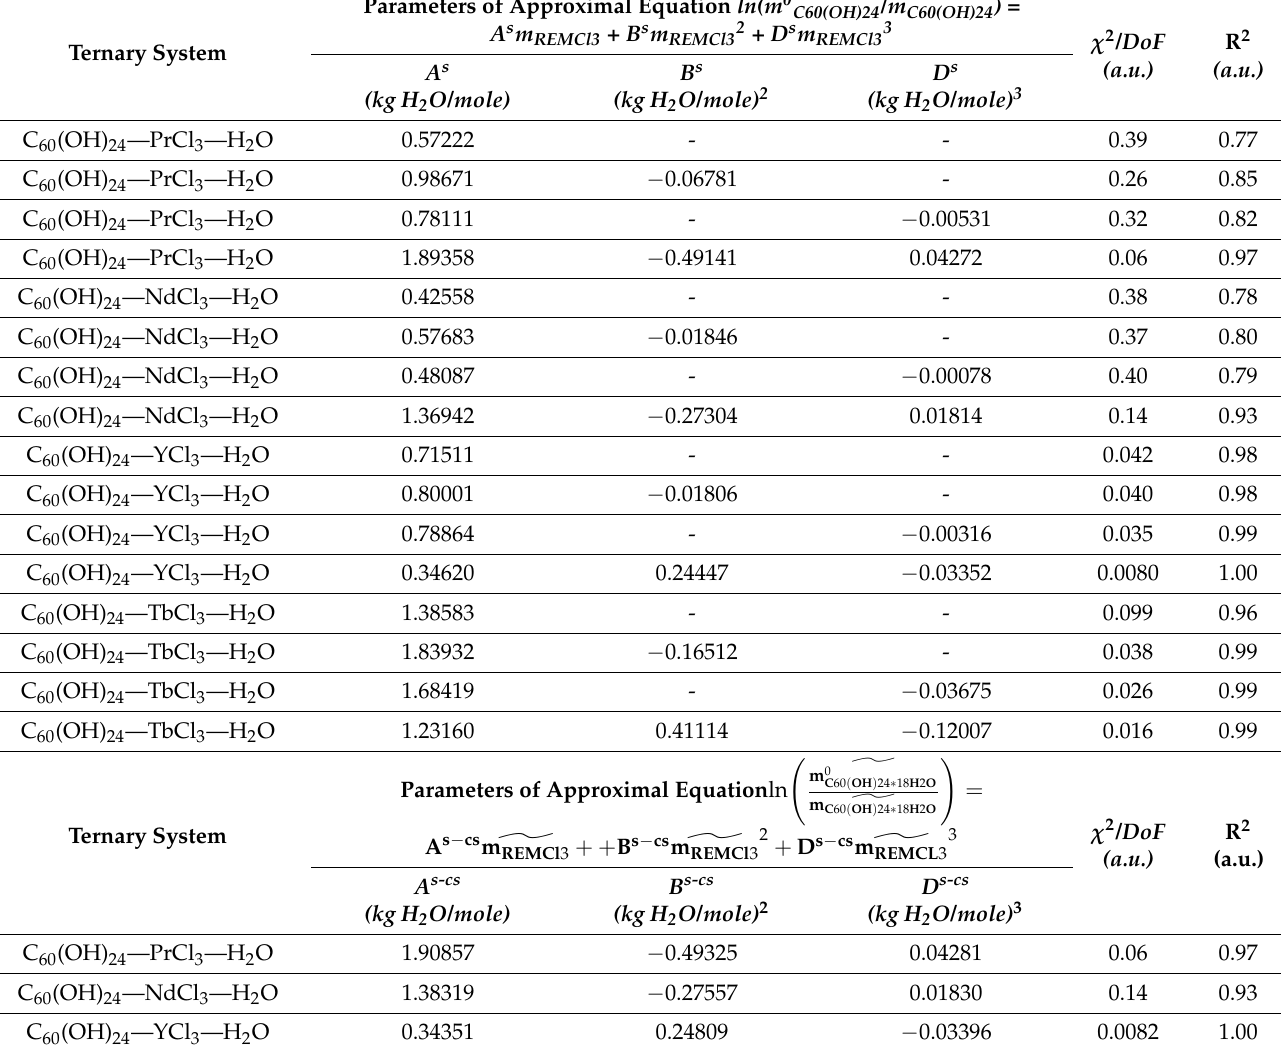
Table 2. Model parameters for the description of C 60 (OH) 24 *18H 2 O crystallization branches in triple systems PrCl 3 — tion quality parameters ( χ 2 /DoF and R 2 ) are also presented there. The Pearson criterion of approximation quality χ 2 /DoF is given by the relation: χ 2 /DoF = (1/v) ∑ [F(obs) i –F(appr) i ] 2 /F(obs) i , where: Summation is carried out for all experimental points from i = 1 to i =N —the number of experimental points (in our case, 14,